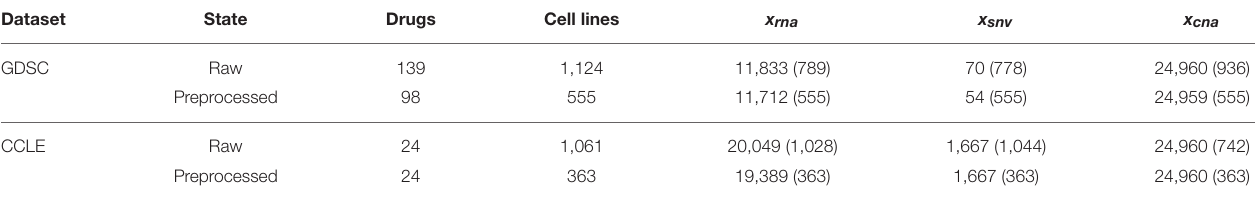
TABLE 1 | Total numbers of samples for three features.